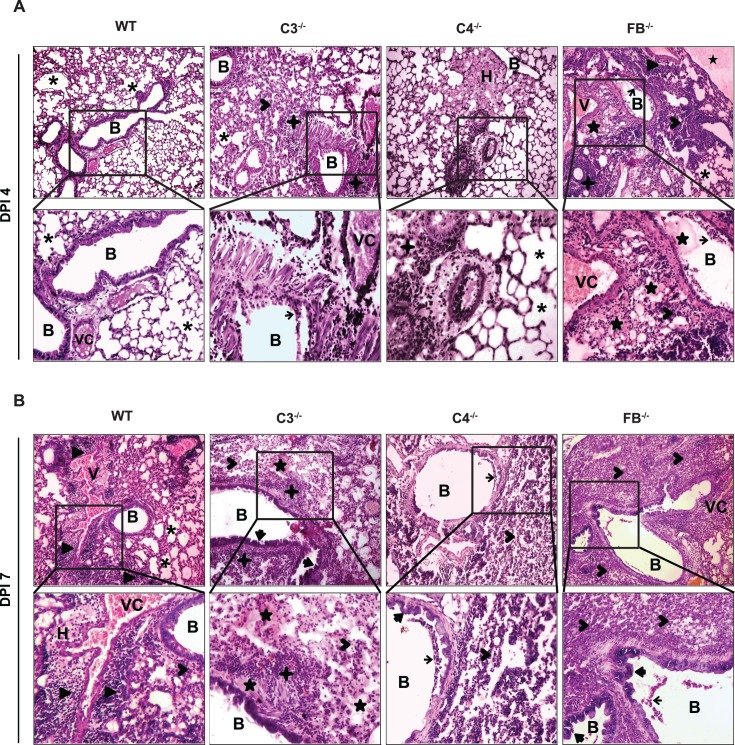
Complement deficient mice infected with A(H1N1)pdm09 virus show increased lung inflammation.WT (C57BL/6) and complement deficient mice (C3-/-, C4-/- and FB-/- mice on C57BL/6 background) were infected intranasally with the pandemic influenza virus (450 TCID50), euthanized at day 4 (panel A) or 7 (panel B) post-infection, and lungs were harvested for histopathology. Sections were stained with H & E and are representative of each group (n = 6, in each group). Magnified view (400X) of the marked area for each panels are displayed in the bottom rows. C3 and FB deficiency was associated with increased inflammatory changes compared to C4 deficiency. Typical histopathological changes include: Emphysema (asterisk), Edema (star), Peri-bronchial (plus) and peri-vascular (filled arrowhead) lymphoid cell infiltrate, parenchymal MNC infiltration (unfilled arrowhead), Hyperplasia (filled arrow), and Sloughing (unfilled arrow). B = bronchi, H = hemorrhage, V = blood vessel, VC = vascular congestion. Original magnification = 100X.